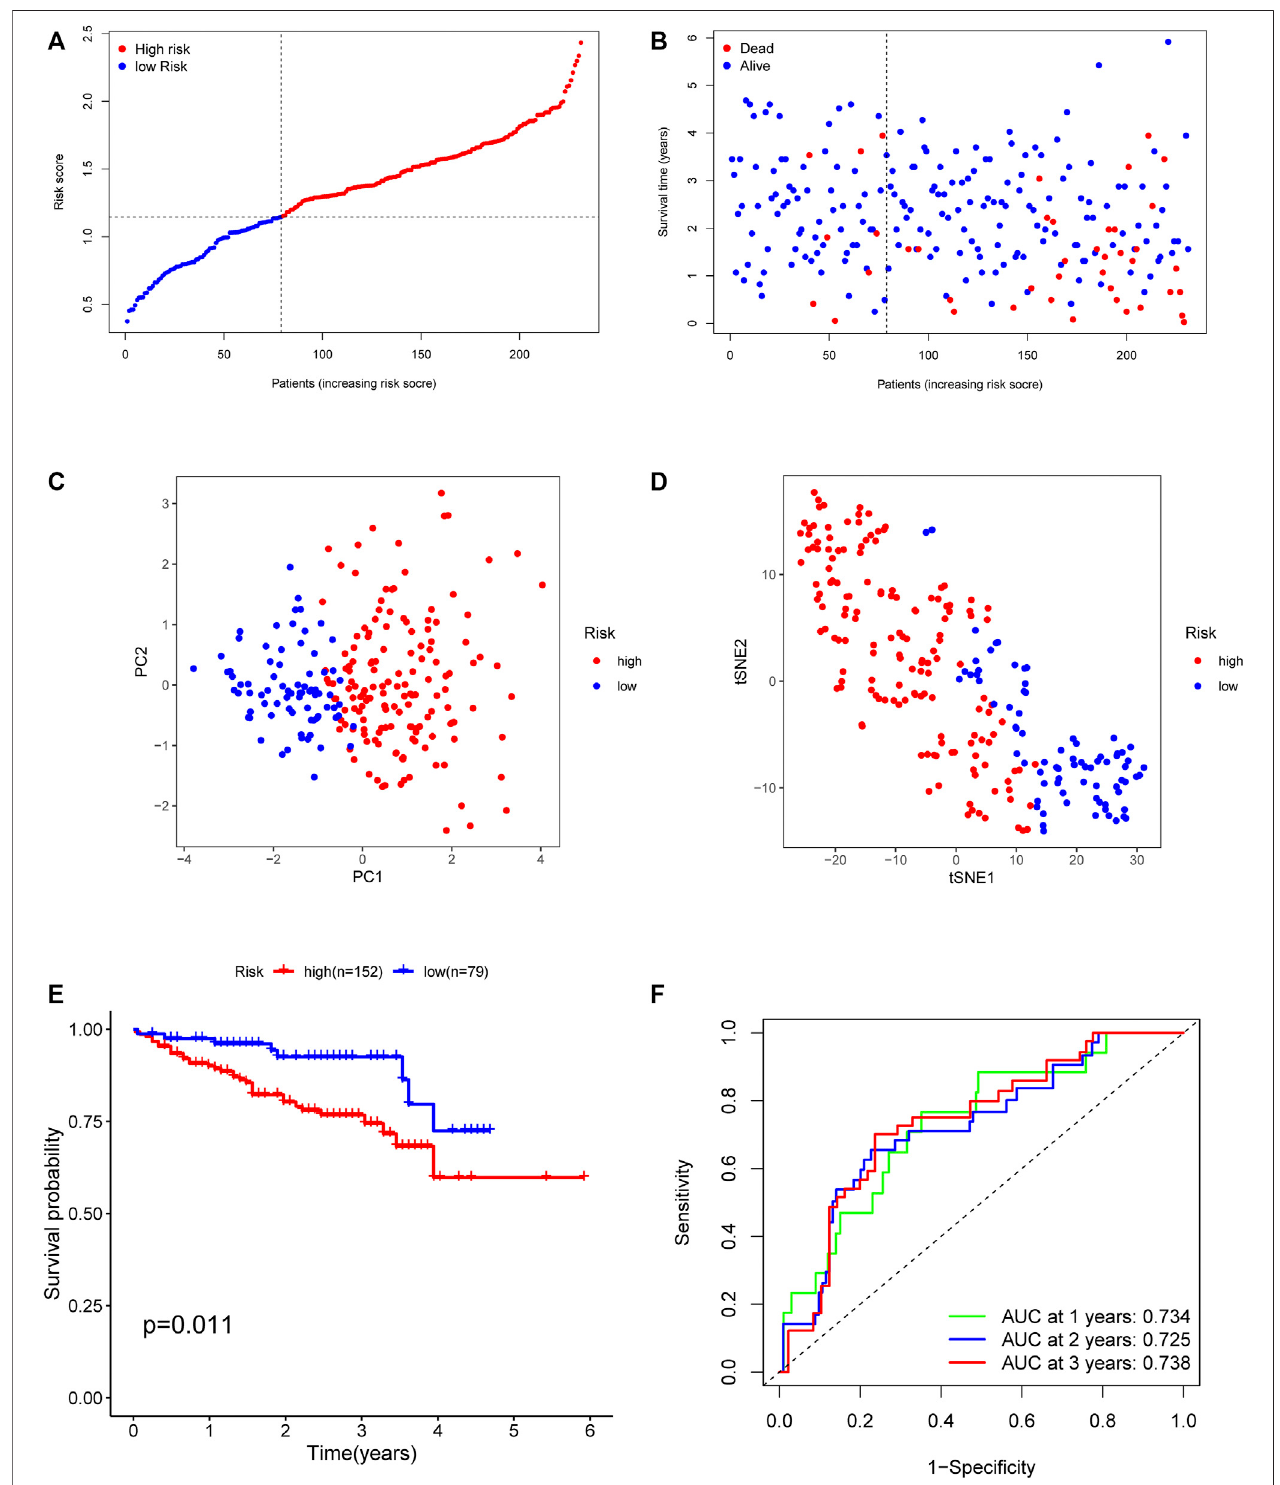
FIGURE5| ValidationoftheriskmodelintheICGCcohort. (A) ThemedianvalueofriskscoreswithsurvivalandstatusesofHCCpatientsdependsonthe fi ve-gene risk model in the ICGC cohort. (B) The distribution ofrisk scores with survival and statusesof HCC patients depends on the fi ve-gene risk model in the ICGC cohort. (C) Principal componentanalysisofHCC patients intheICGCcohort. (D) t-SNE analysisofHCC patientsintheICGC cohort. (E) Survivalanalysisofpatients inthe high-risk group and low-risk group based on the prediction risk score formula. (F) One-, two-, and three-year ROC curves of the bene fi t model for assessing the prognostic performance of the gene signature in the ICGC